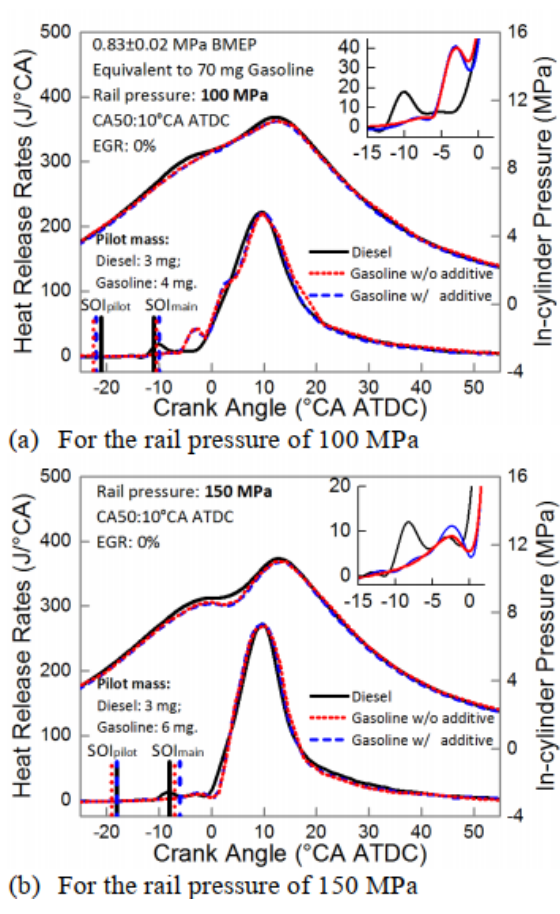
Fig. 15 Effect of injection pressure on combustion